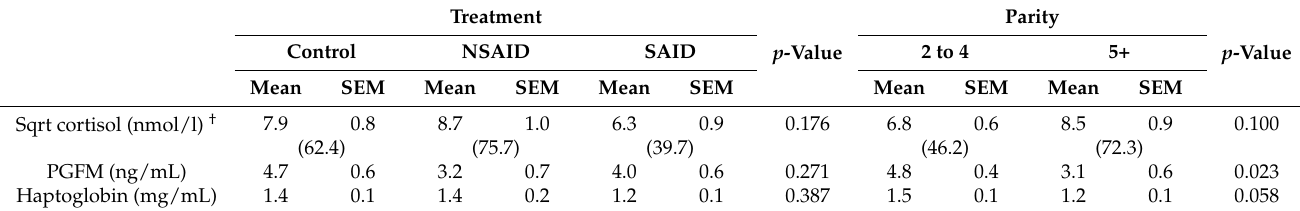
Table 2. Day 2 plasma square root (sqrt) cortisol, PGFM and haptoglobin concentrations in sows injected with either saline (Control), a nonsteroidal anti-inflammatory (NSAID), or steroidal anti-inflammatory (SAID) prior to farrowing, and those of parity 2 to 4 and 5+. † Back-transformed means are presented in